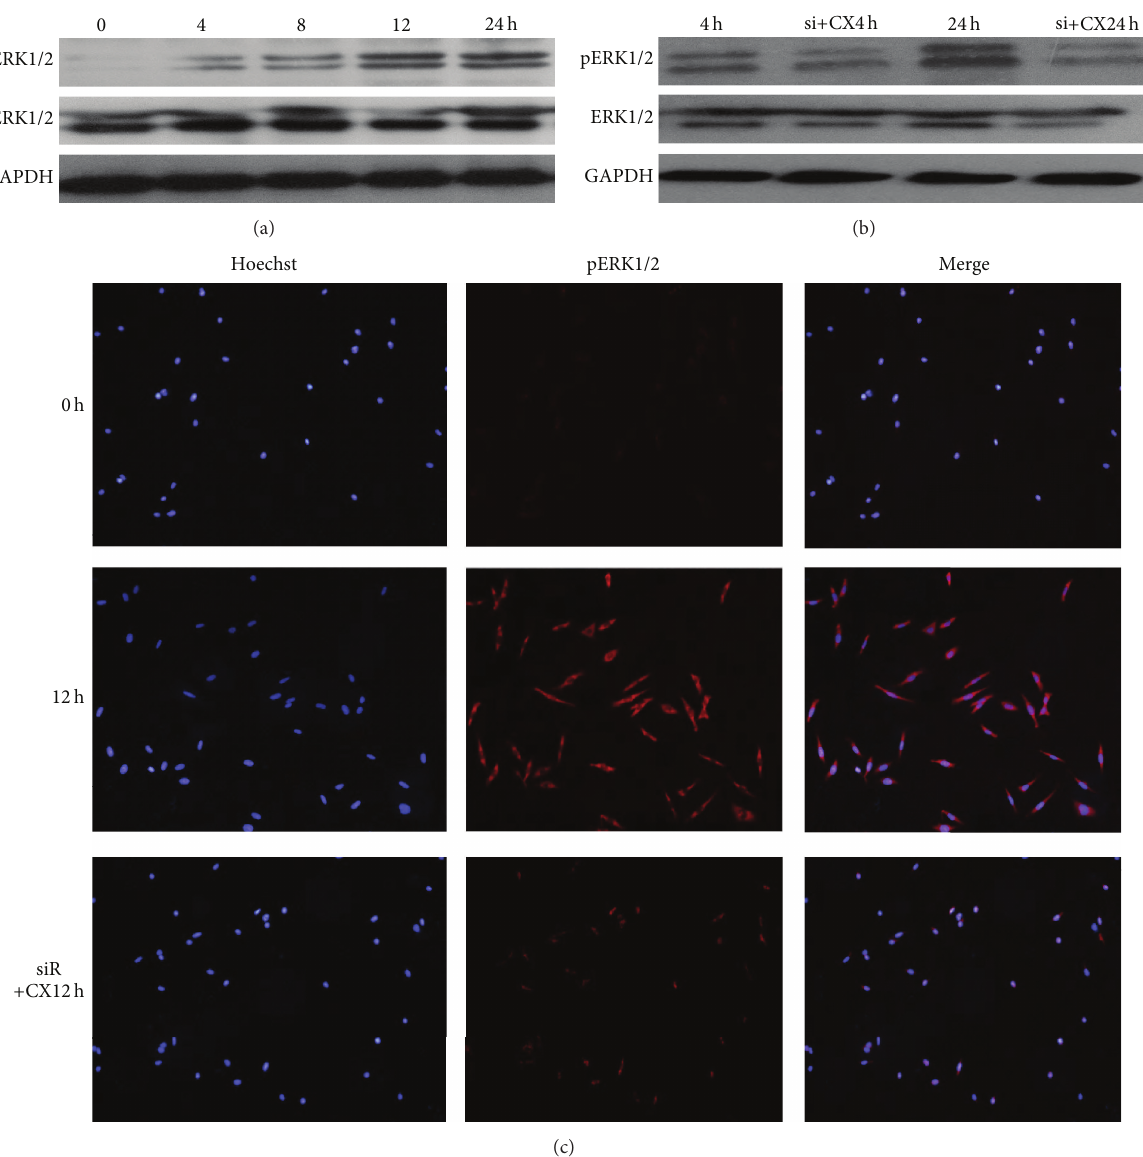
Figure 4: CXCL13triggered ERKtyrosinephosphorylation. (a) Upon 4 hours, CXCL13triggered ERKtyrosinephosphorylation of HRMCsas time went on. (b) ERK tyrosine phosphorylation decreased in CXCL13 treatment after the silence of CXCR5 compared to CXCL13 treatment alone. (c) The same result with (a) and (b) was found by immunofluorescence. The top row was detected at 0 hours and the middle at 12 hours after CXCL13 treatment. The bottom presented pERK of cells treating with CXCL13 for 12 hours after